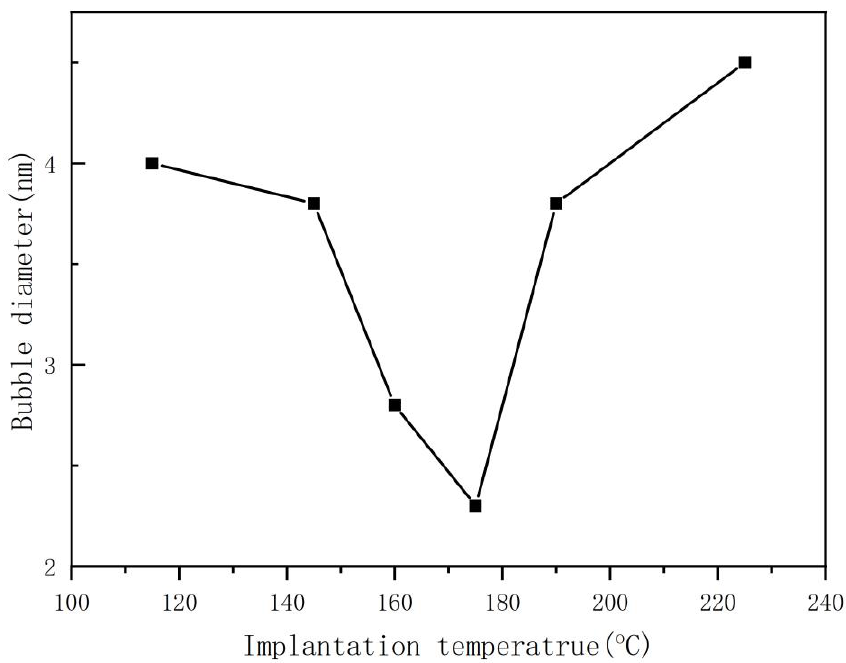
Figure 2. Dependence of the average helium bubble diameter on the helium ion implantation temperature (helium ion dose 5 × 10 16 ions/cm 2 , helium ion energy 100